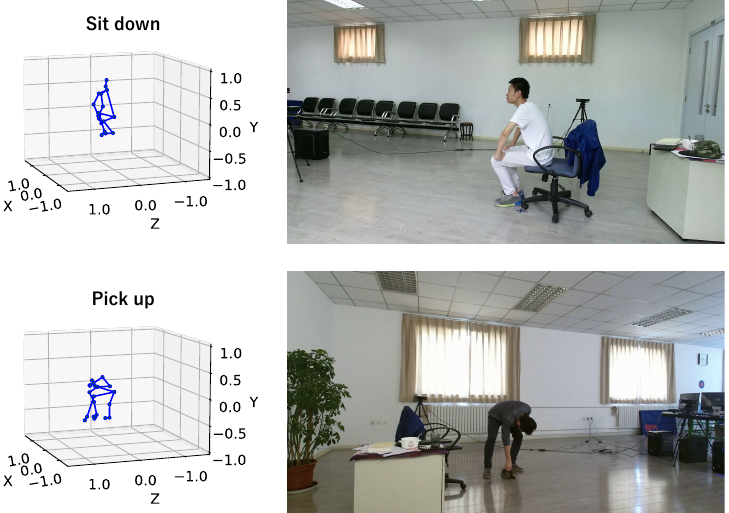
Figure 6. Examples of 3D skeletons and RGB images in the PKU-MMD dataset. The upper one shows “sit down” and the lower one shows “pick up”. The 3D human skeletons are on the left and the RGB image are on the